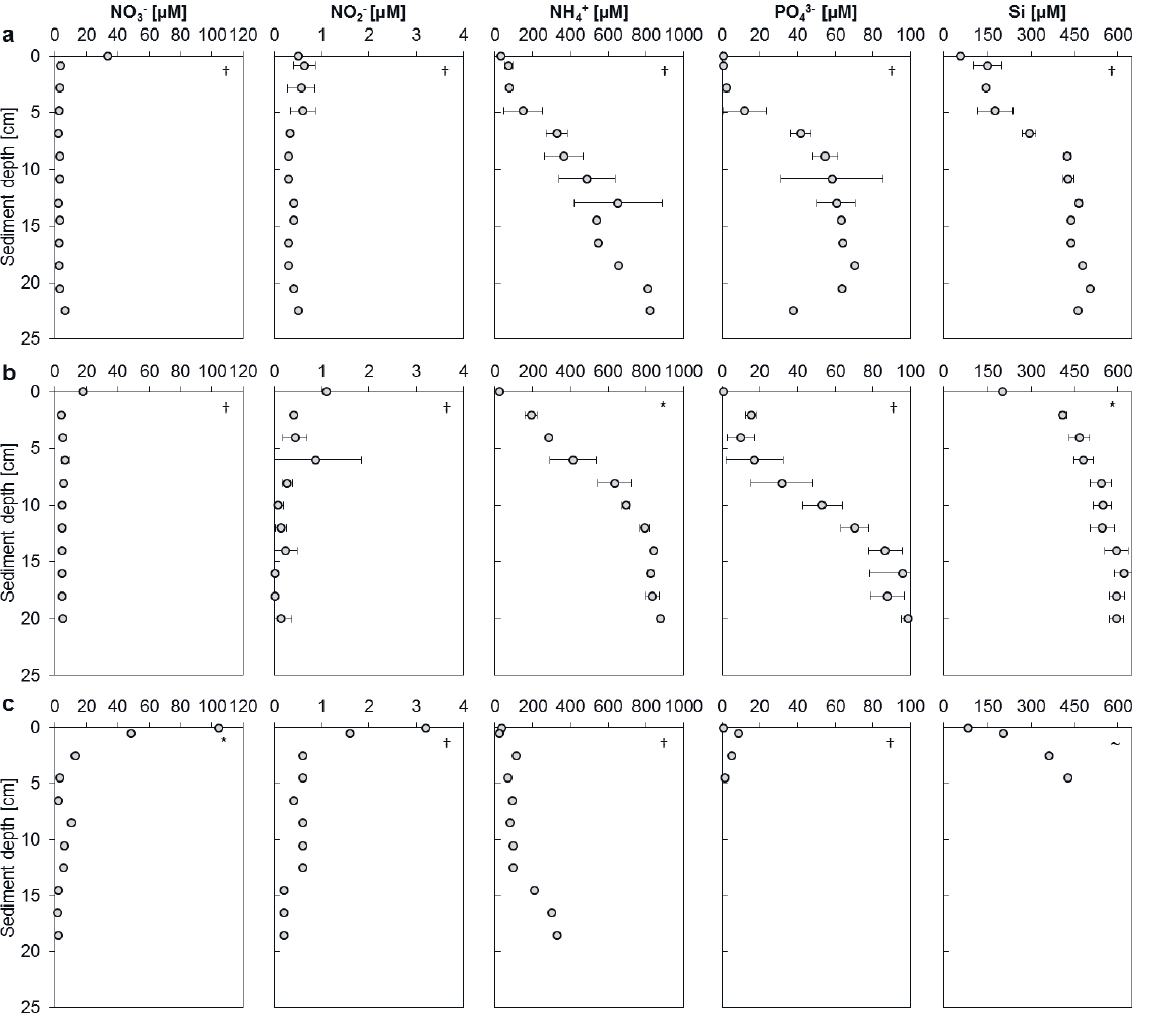
Figure 3. Pore water nutrient concentration profiles of mangrove sediment cores during spring (March) ( a ); regular summer (September) ( b ); and post-storm conditions in October ( c ). In ( c ) no data is available for PO 43 − and Si below 5 cm sediment depth. Significantly different concentrations in surface sediments between samplings are marked by different symbols in the top right corner of panels (<0 cm, >5 cm; one-way ANOVA, p <